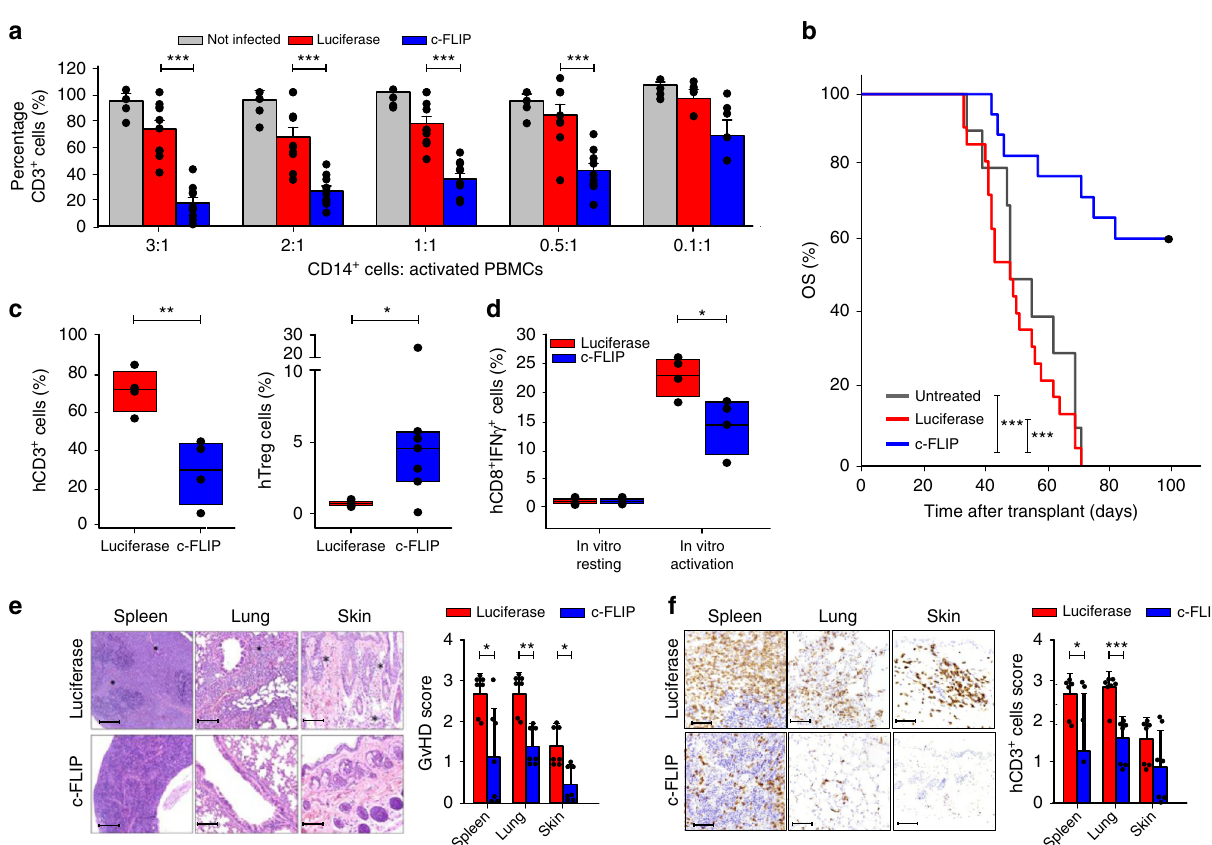
Fig. 3 c-FLIP-engineered monocytes transfer controls GvHD progression. a Immunosuppressive functions of CD14 + monocytes freshly isolated from buffy coats of healthy donors and infected with either luciferase- (as control) or c-FLIP-expressing lentivirus vector was measured by enumeration of absolute number of human CD3 + T cells collected after co-culture with engineered monocytes. b Kaplan – Meier survival analysis of mice developing xenogeneic GvHD and treated with adoptive cell therapy based on the administration of human engineered, c-FLIP-expressing monocytes: untreated mice, n = 10; luciferase- treated mice, n = 22 and c-FLIP-treated mice, n = 18. c Frequency of circulating human CD3 + T lymphocytes and Treg (CD3 + CD4 + CD25 + FoxP3 + cells) in mice with GvHD treated with the administration of either luciferase- or c-FLIP-expressing monocytes. d Percentage of IFN- γ -producing human CD8 + T cells isolated from the spleen of mice with GvHD treated with the administration of either luciferase- or c-FLIP-expressing monocytes and stimulated in vitro with polyclonal activators (PMA/IONO). e Representative histological analysis of tissues (spleen, lung, and skin) of mice developing GvHD and treated with human-engineered monocytes. Analysis was performed at day 70 after PBMC transplantation. f Human CD3 + T cell in fi ltration in tissues (spleen, lung, and skin) of mice developing GvHD and treated with engineered monocytes. Analysis was performed at day 70 after PBMC transplantation. Data are presented either as mean±s.e.m of fi ve independent experiments ( a ) or as mean±s.e.m of seven independent samples ( c – f ) or as cumulative data of three